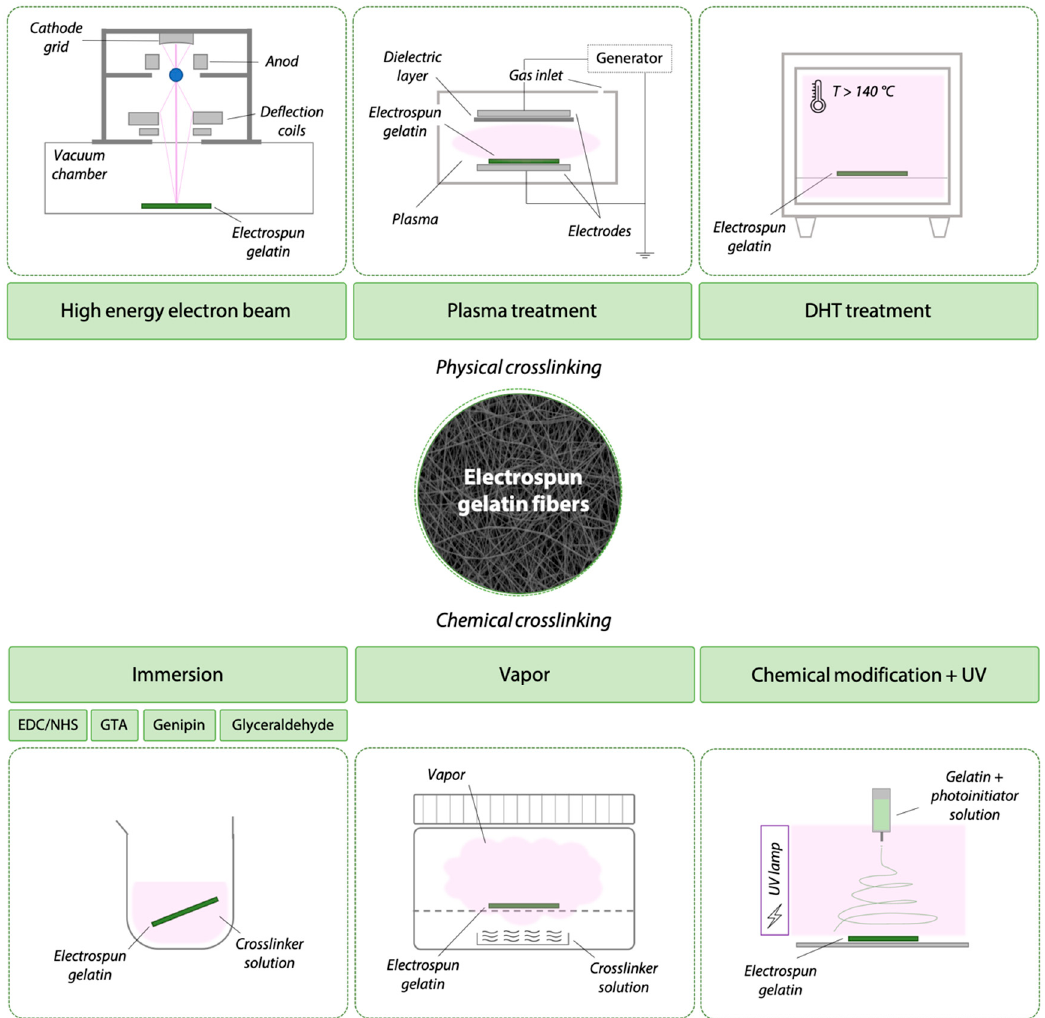
Figure 3. Schematic representation of cross-linking strategies used for the stabilization of electrospun gelatin matrices. Physical cross-linking can be performed by high energy electron beam, plasma treatment, or dehydrothermal treatment. Chemical cross-linking can be performed by immersion in a cross-linking solution, by using vapors of the cross-linker, or by chemically modifying gelatin to subsequently cross-link it by UV irradiation.